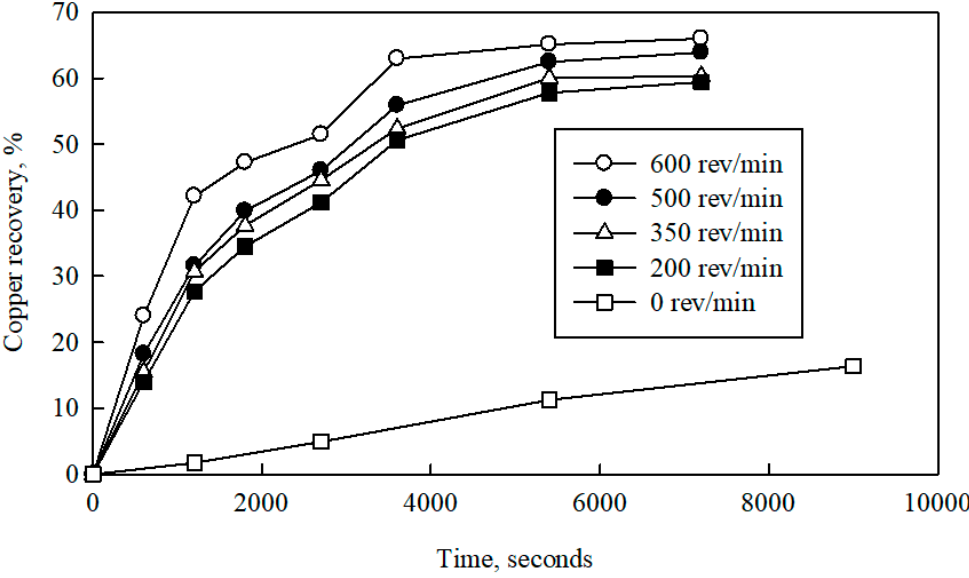
Figure 6. The effect of stirring rate on the malachite dissolution. Working conditions: NH 4 OH = 0.1 mol / dm 3 , temperature = 298 K, pH = 10.5, particle size = 5 µ m and S / L ratio = 1:1000.